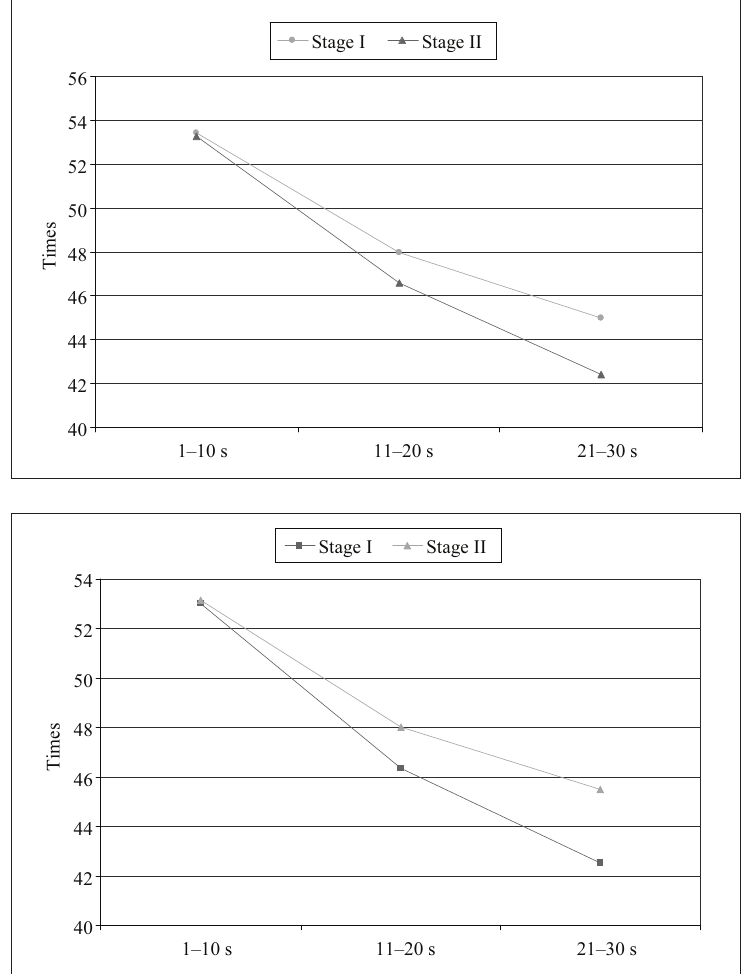
Figure 2. Changes in the frequency of hand movements for boys in 30